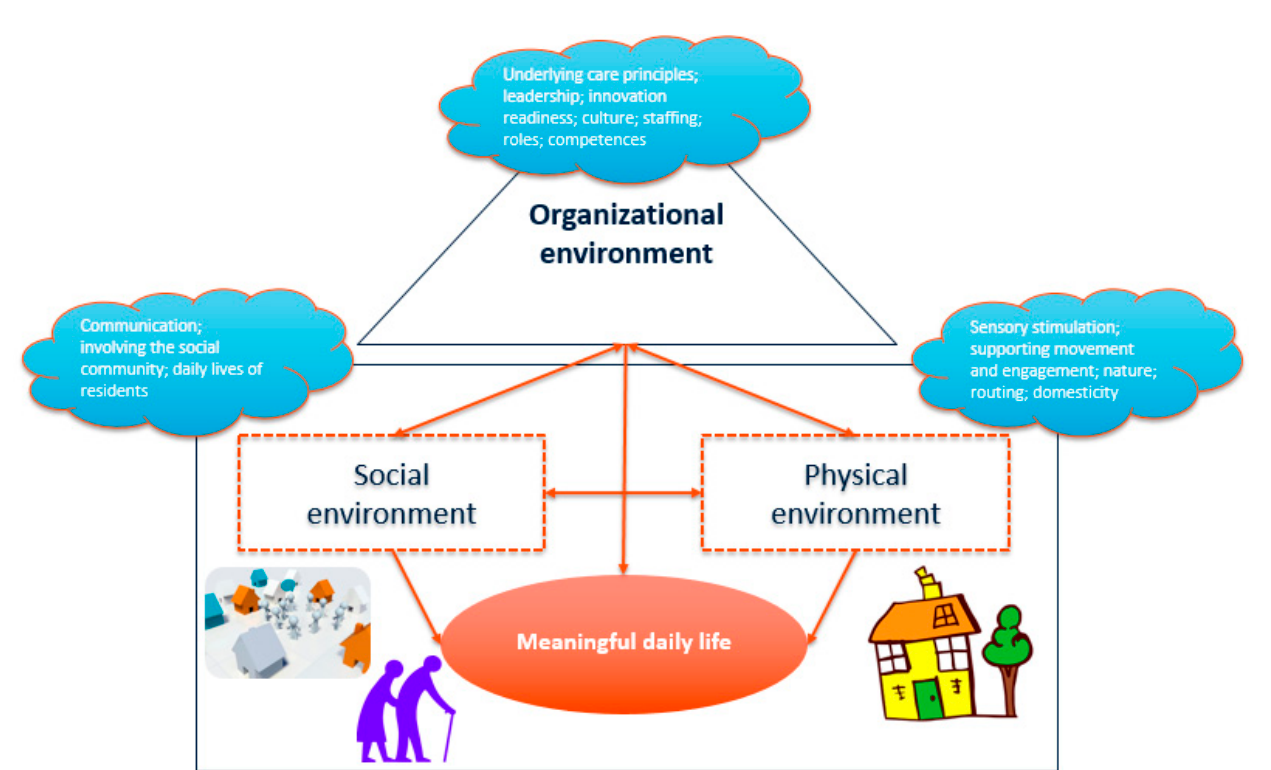
Figure 1. Underlying theoretical framework which integrates the physical, social and organizational environment.